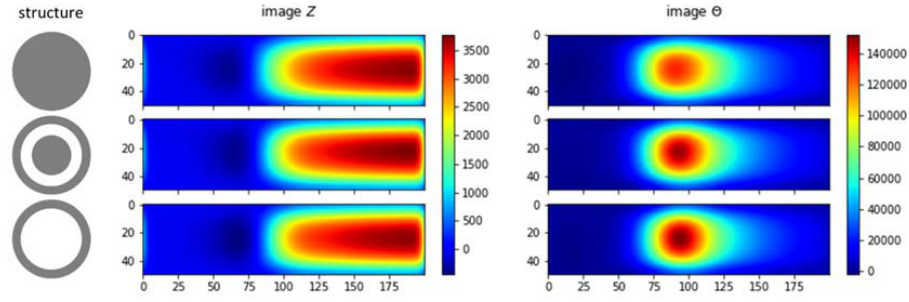
Figure 21. Z- θ spectrum metallic structures: hollow, hollow-with-inclusion,